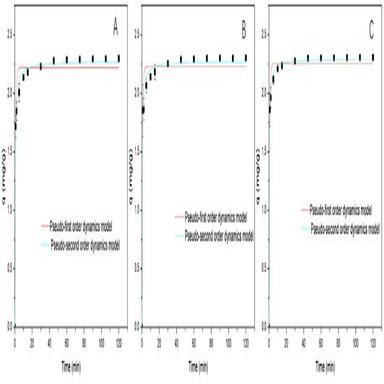
The adsorption kinetics of Cr(III)-cit at (A) 15 ◦C, (B) 25 ◦C and (C) 35 ◦C.